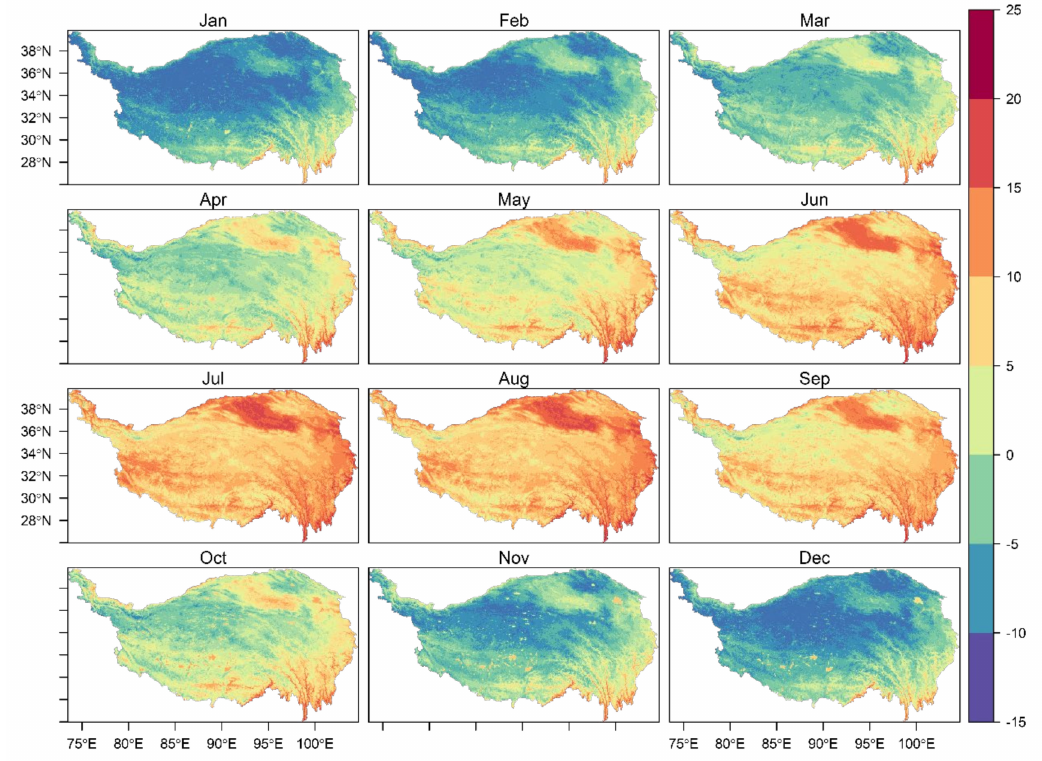
Figure 7. Monthly Tmean based on RF model in